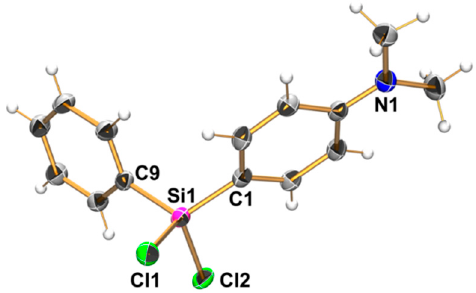
Figure 1. Molecular structure of (4-Me 2 N-C 6 H 4 )PhSiCl 2 in the crystal, thermal displacement ellipsoids are drawn at the 50% probability level. Selected bond lengths (Å) and angles (deg): Si1–C1 1.841(2),